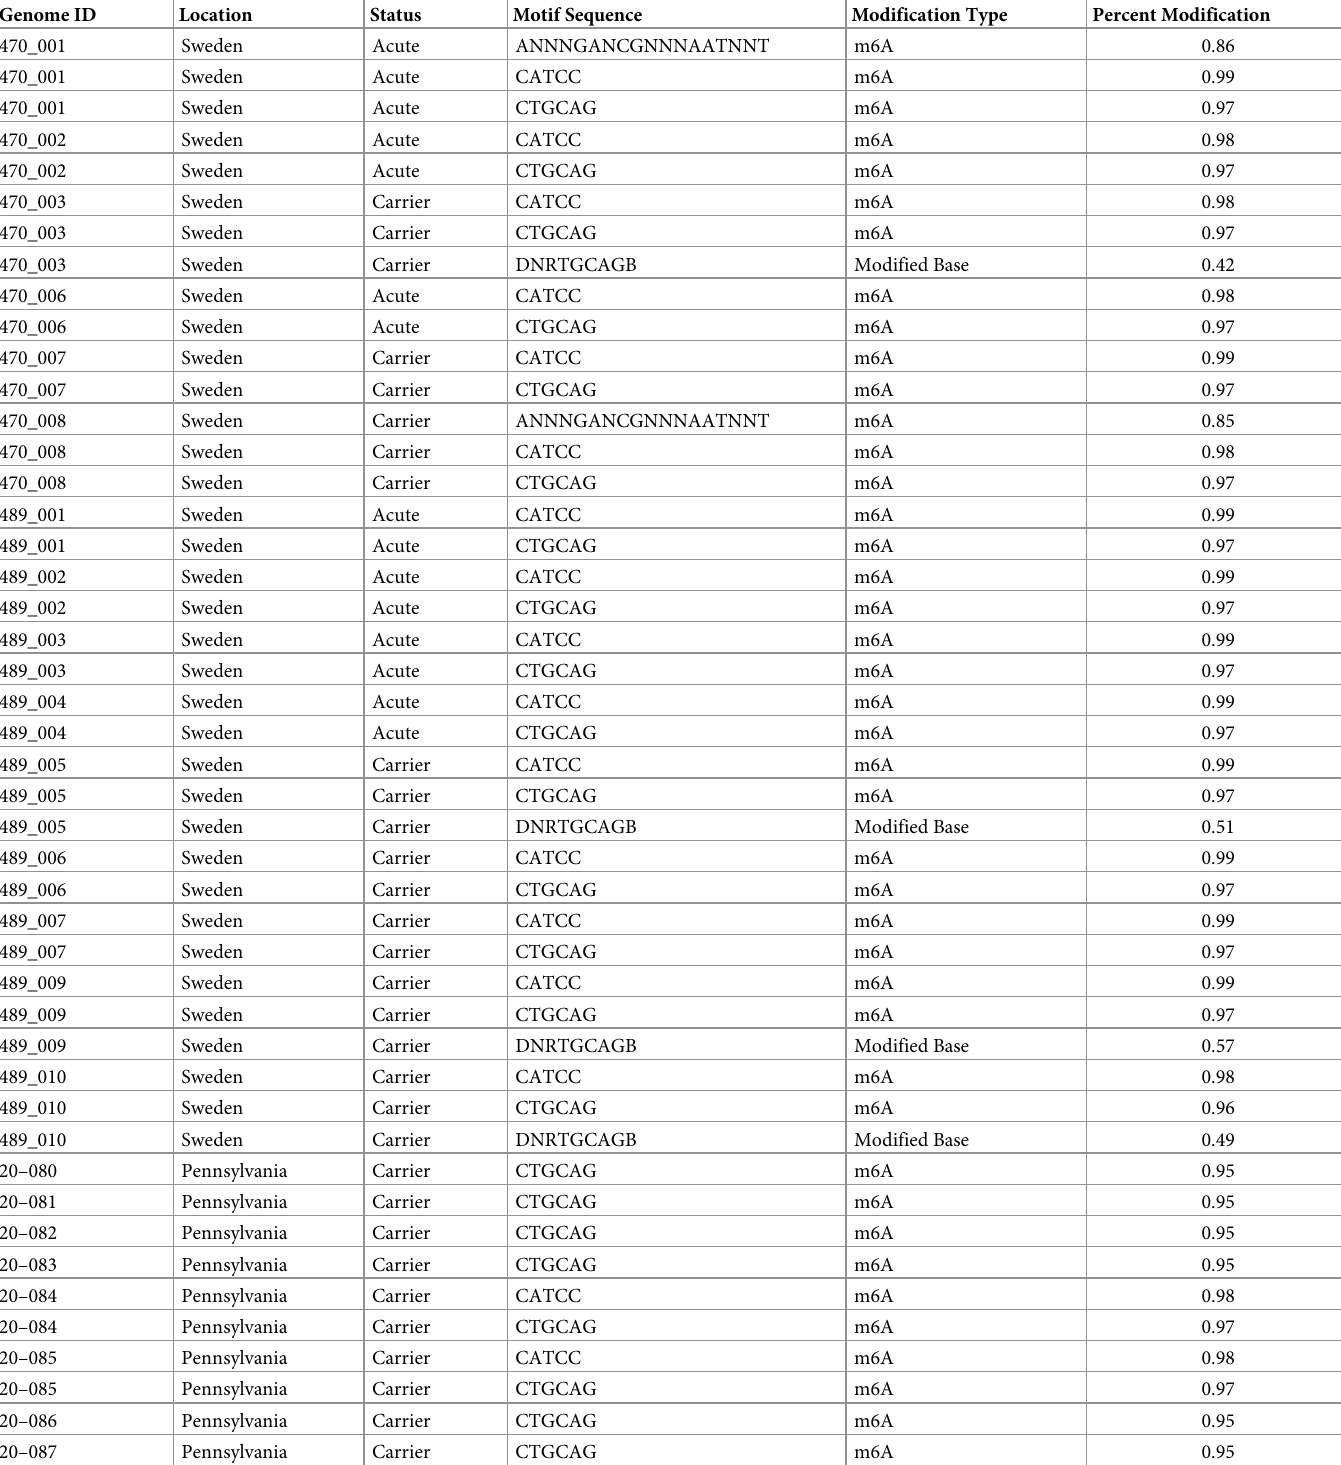
Table 2. The summary of the methylation motif sequences, modification types, and modification percentage for all study SEE isolates from Sweden and Pennsylvania. Genome